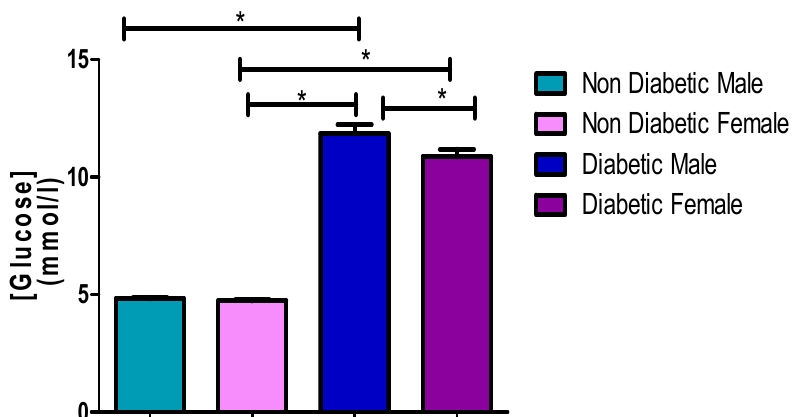
Figure 1. Fasting glucose concentrations. *, a significant statistical di ff erence ( p -value < 0.05). The statistical bar ( statisticaldi ff erenceinthefastingglucoseconcentrationbetweenthenon-diabeticmaleanddiabeticmale, between the diabetic male and diabetic female, respectively.